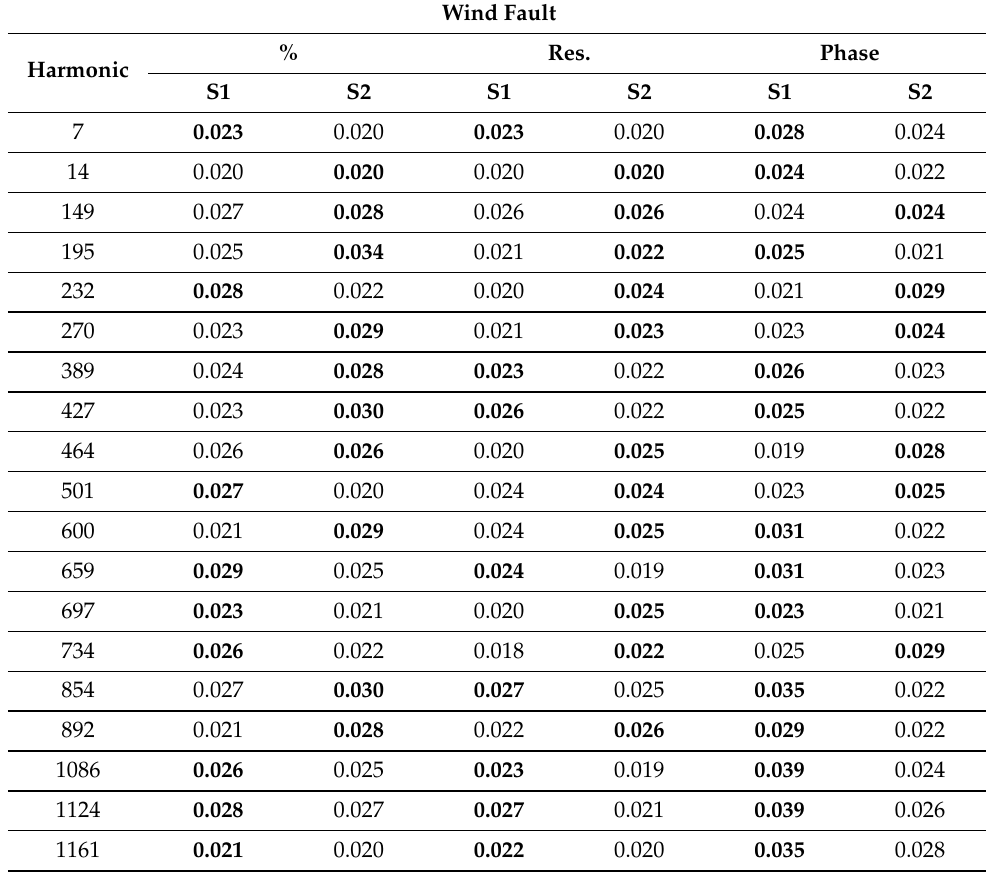
Table 7. RMSE for Wind-Fault Harmonic